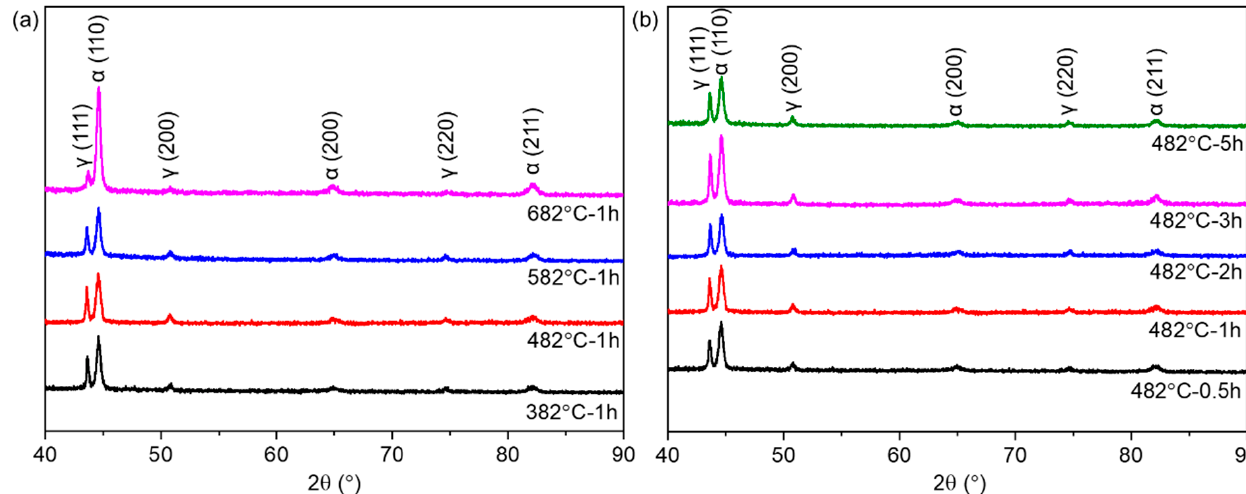
Figure 6. XRD spectra of the SLM-manufactured 17-4 PH steel samples under different ( a ) aging temperatures and ( b ) aging times. Table 2. Volume fractions of the α ’-Fe and γ -Fe phases in the SLM 17-4 PH steel samples under di ff erent states.